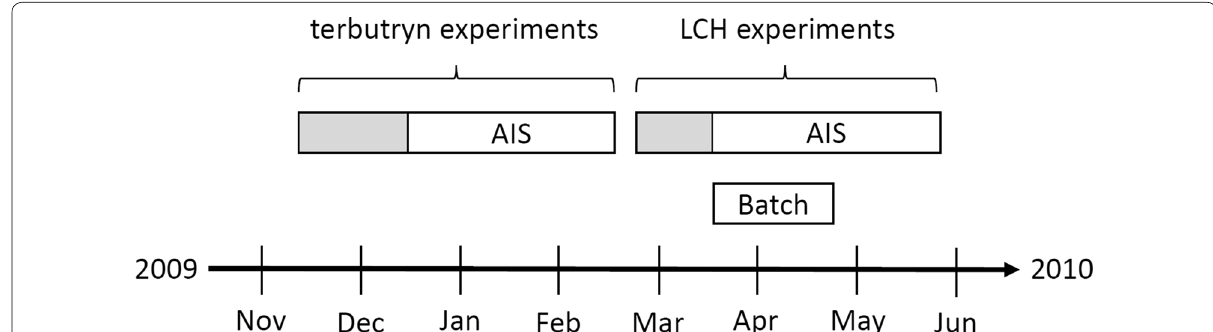
Fig. 1 Timing of the different experiments. Grey areas of the AIS experiments indicate the pre-application period, the white areas are the exposure